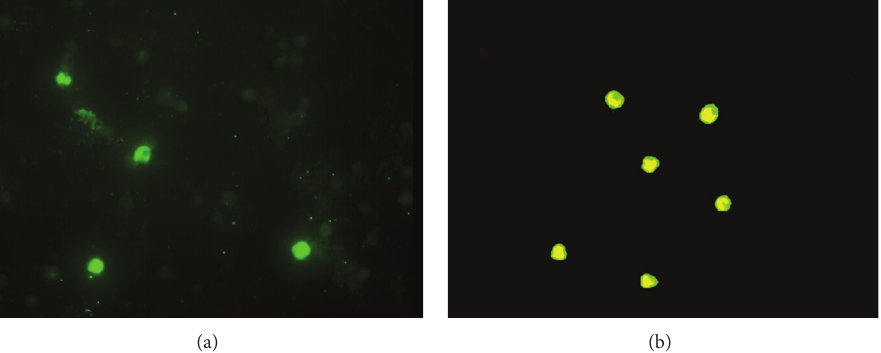
Figure 1: Demonstration of dengue viral antigen in monocytes of patients infected with dengue virus as dengue viral antigen positive-stained cells in panel (a) and double-stained for dengue viral antigen and CD14 positive cells in panel (b).